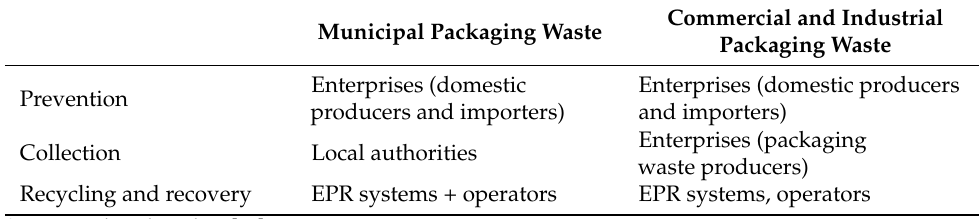
Table 3. Responsibilities for prevention, collection, recycling, and recovery in the UK.